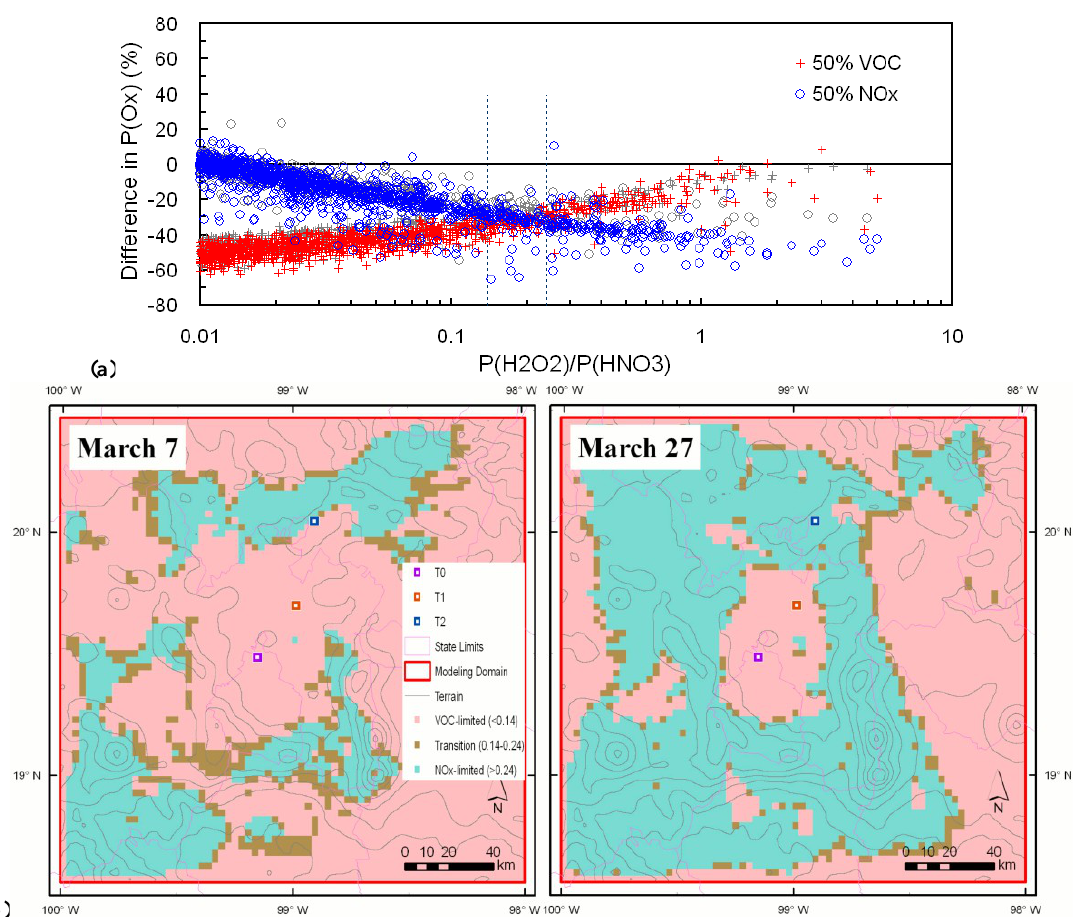
Fig. 12. (a) The percentage change in O x formation rate as a function of the indicator, ratio of H 2 O 2 production rate to HNO 3 production rate at 12:00–17:00LT during the episodes (weekends are shown in gray) within the urban area. The dashed bars envelop the transition regime. (b) Spatial distribution of the ratio at 14:00LT on 7 and 27 March indicating the NO x -VOC sensitivity. Topography contour intervals are 400 meter.